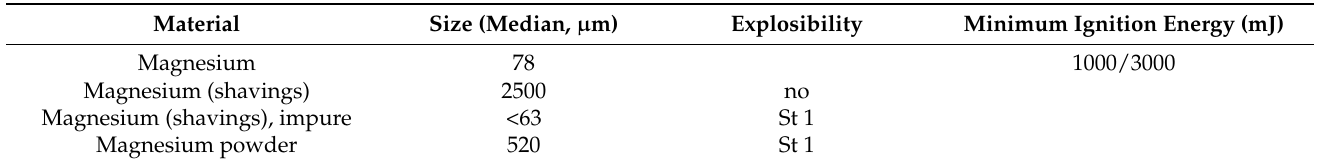
Table 2. Gestis dust explosion data for magnesium. Source: